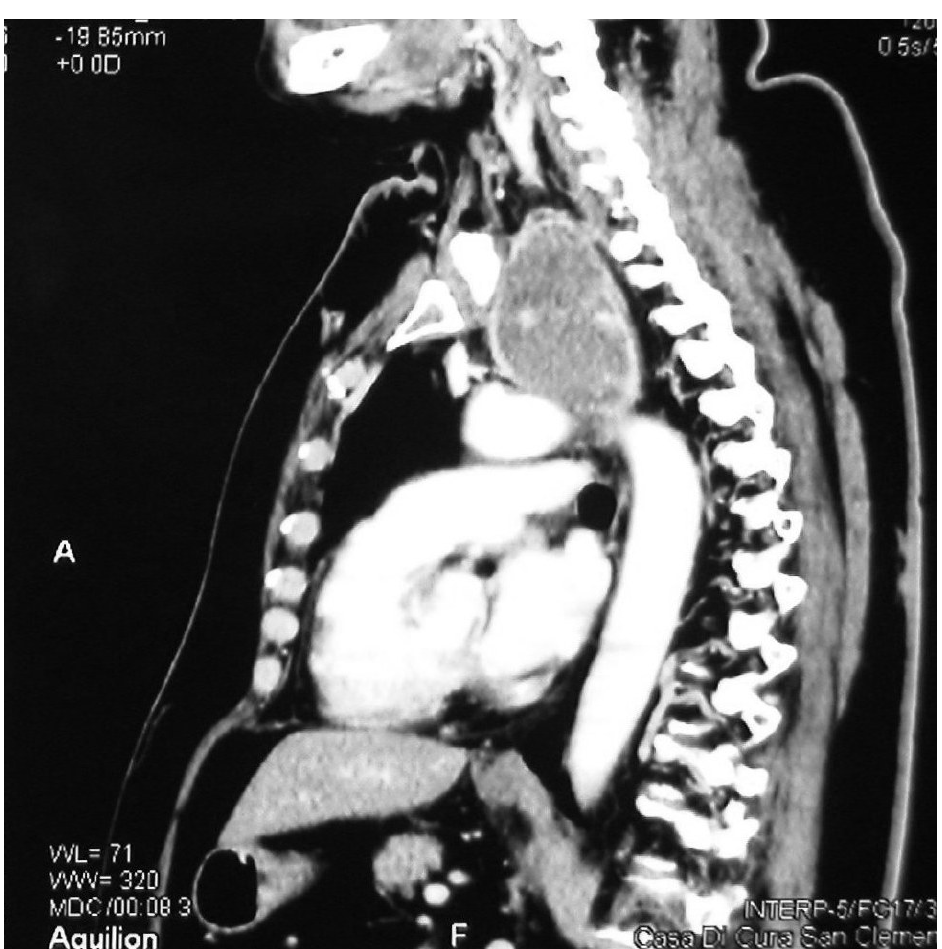
Figure 2. Sagittal CT showing a retrovascular retrosternal